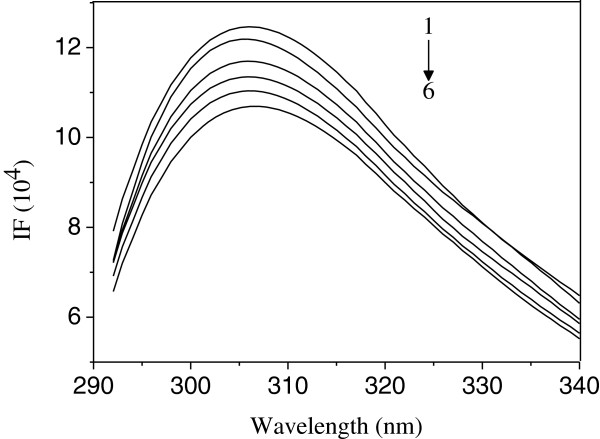
Fluorescence spectra of SOD in the presence of various concentrations INH at 299 K (pH = 7.4, λex = 280 nm).c(SOD) = 4.0 × 10−6 mol · L−1; c(INH)/(10−5 mol · L−1), 1–6: 0, 0.8, 1.6, 2.4, 3.2, 4.0, respectively.